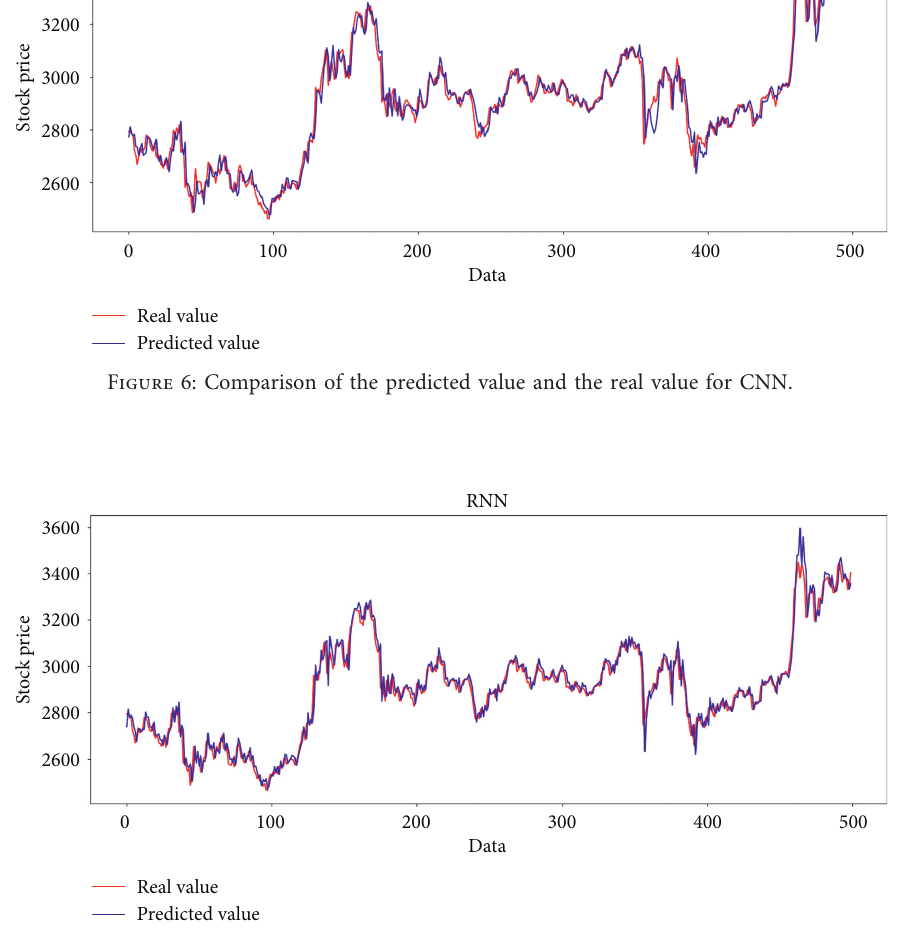
Figure 7: Comparison of the predicted value and the real value for